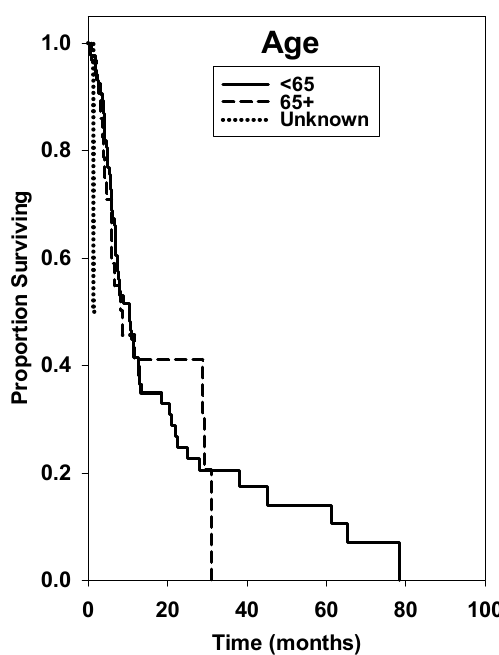
Figure 1. Overall survival (OS) curves of patients with ages <65, 65+, or unknown at time of brain metastasis diagnosis.